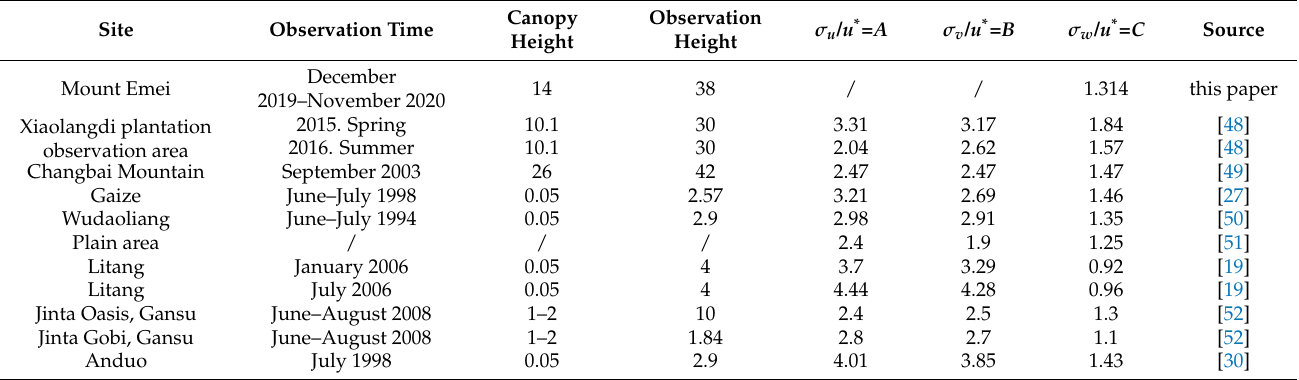
Table 2. The dimensionless wind speed fluctuation variance under near neutral stratification of different underlying